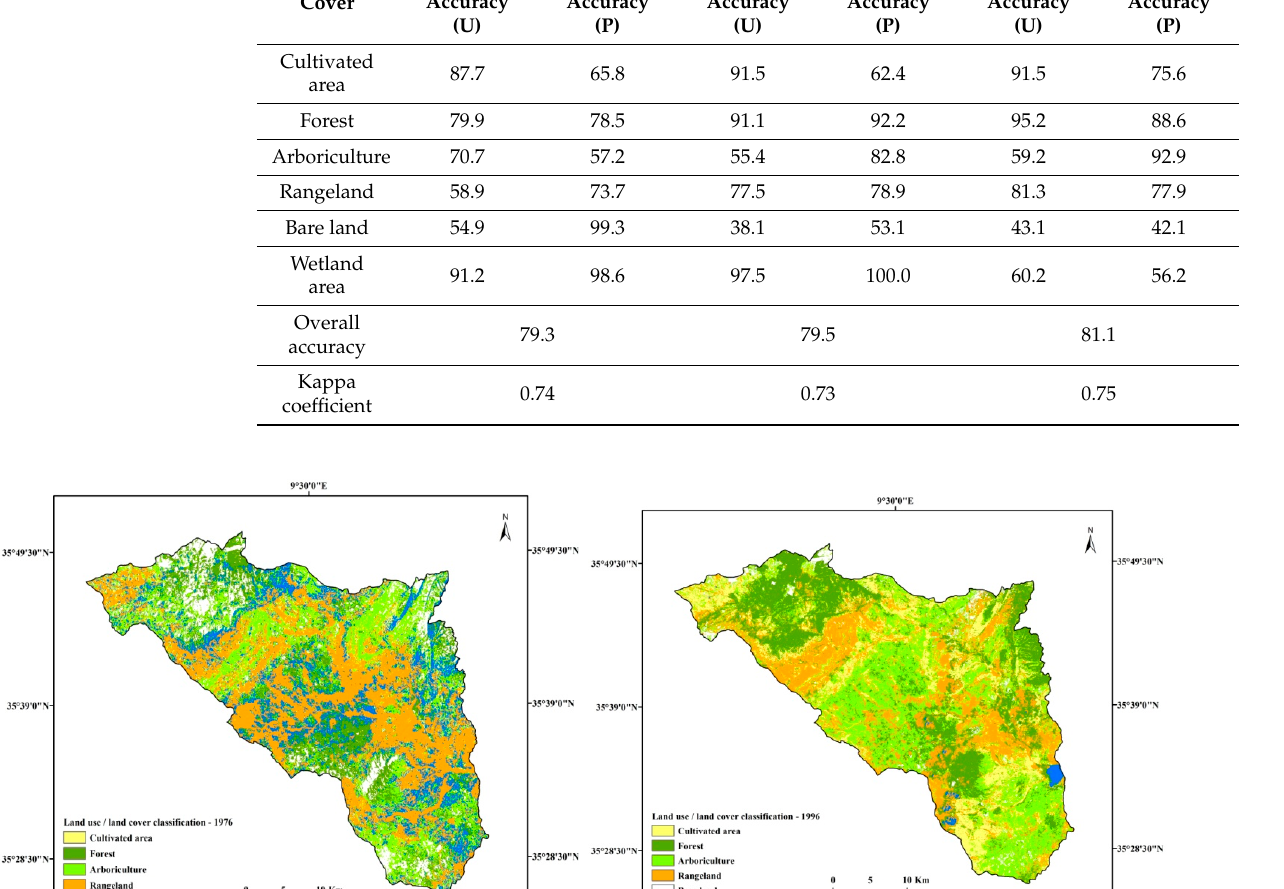
Table 3. Accuracy assessments for land use/land cover classification (%) (1976–2016).